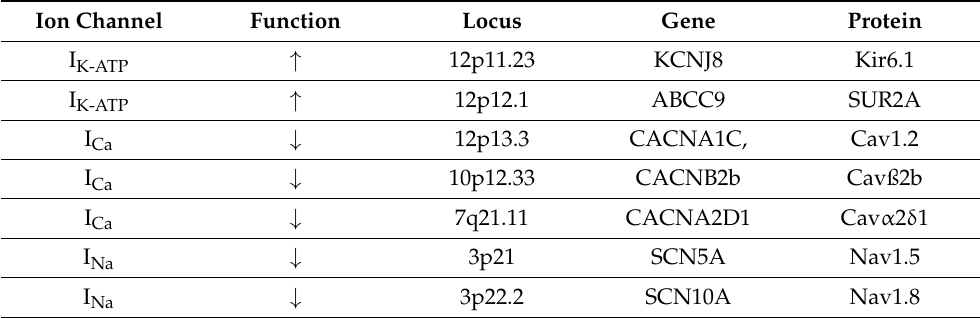
Table 2. Gene defects associated with ERP/ERS, and the corresponding changes of ion channel function